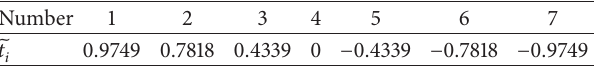
Table 2: Zero points for six-order Chebyshev polynomial fitting.